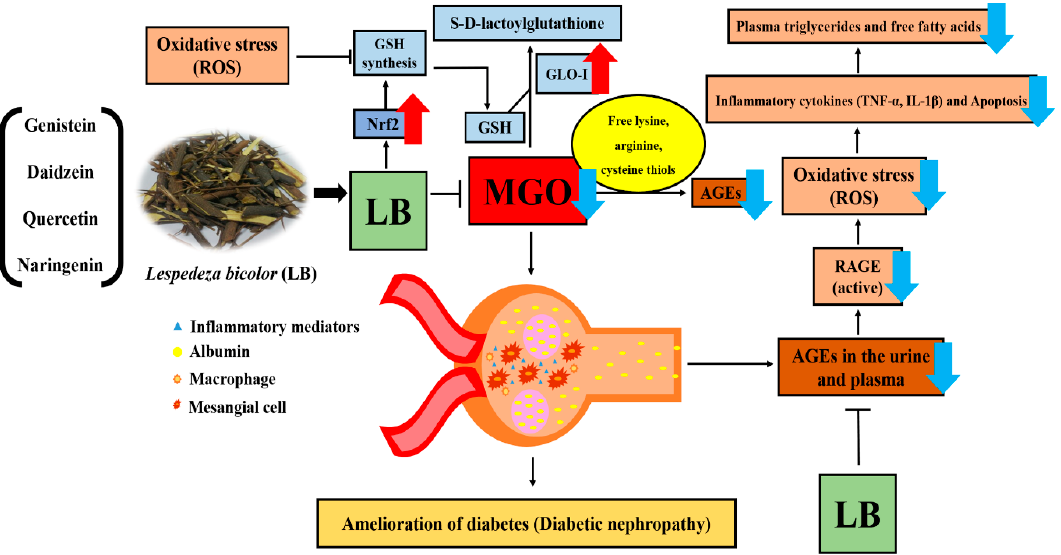
Figure 9. Mechanism of LB action on DM and its related complications. Treatment with